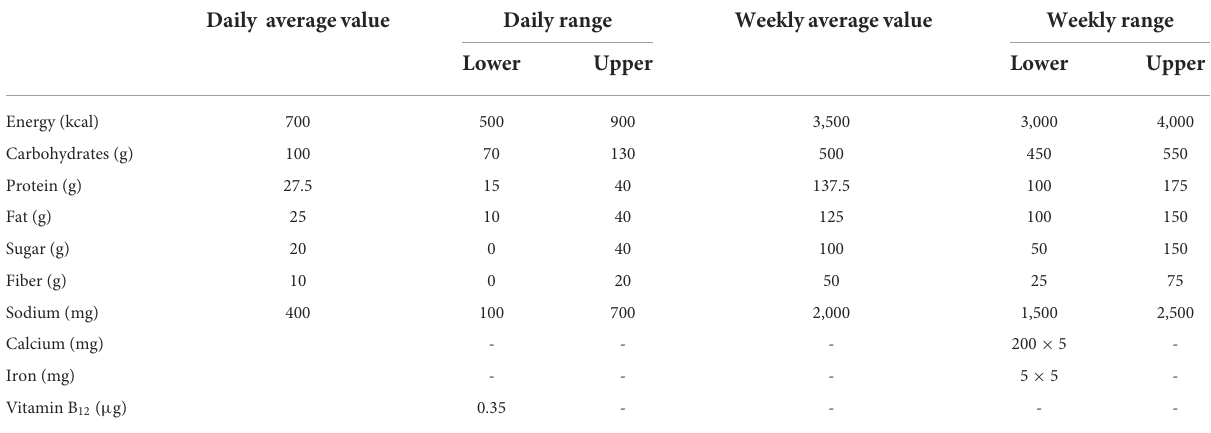
TABLE 2 Lunch energy and nutrient constraints for children aged 6–11